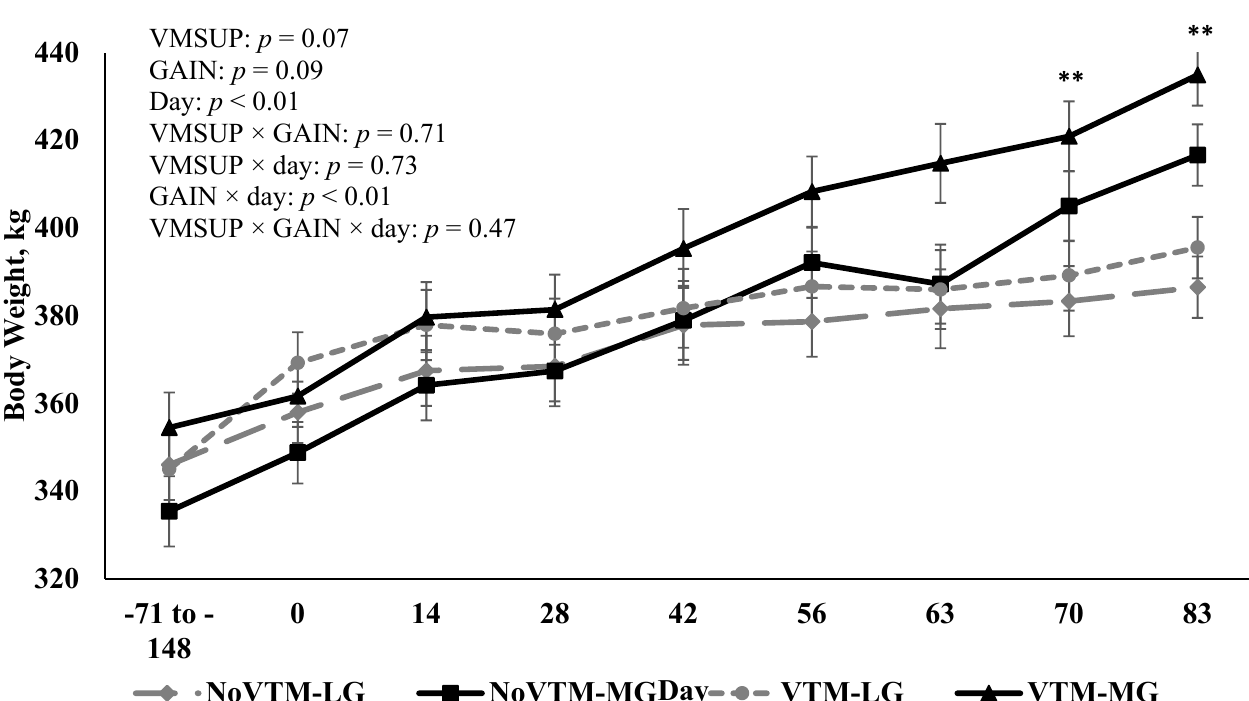
Figure 2. Effect of vitamin and mineral supplementation [VMSUP; supplemented (VTM) vs. unsupplemented (NoVTM); from pre-breeding to d 83 of gestation] and two different rates of gain [GAIN; low gain (LG), 0.28 kg/d, vs. moderate gain (MG), 0.79 kg/d; from breeding to d 83 of gestation] on beef heifer body weight. Because of the seven breeding groups the heifers were assigned to, the extent on which VTM heifers received their treatments varied according to their breeding date. Therefore, the VMSUP factor started within a range of 71 to 148 days before artificial insemination (AI). The AI was considered the d 0 of the experiment—where heifers were assigned to their GAIN treatments— completing our factorial design. NoVTM-LG ( n = 9): No vitamin and mineral supplement, low gain; NoVTM-MG ( n = 9): No vitamin and mineral supplement, moderate gain; VTM-LG ( n = 9): Vitamin and mineral supplement, low gain; VTM-MG ( n = 8): Vitamin and mineral supplement, moderate gain. A GAIN × day interaction ( p < 0.01) was observed for body weight, which was similar between LG and MG from project initiation until d 70; and was greater ( p ≤ 0.04) for MG compared with LG on d 70 and 83, as indicated by **. Values are least squares means, with error bars depicting standard